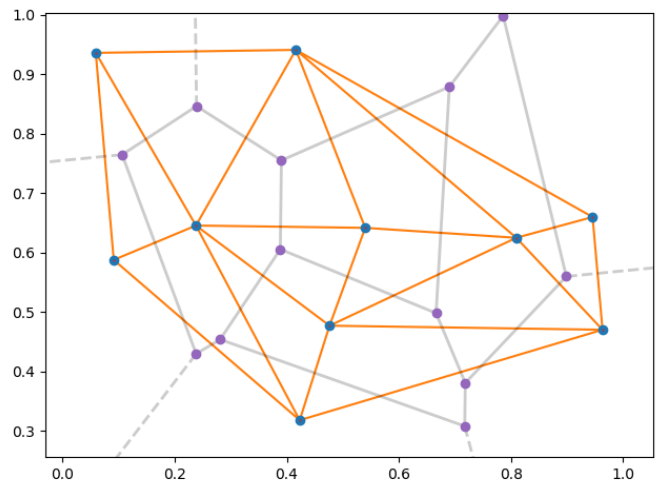
Figure 3. Delaunay triangulation (orange) and Voronoi